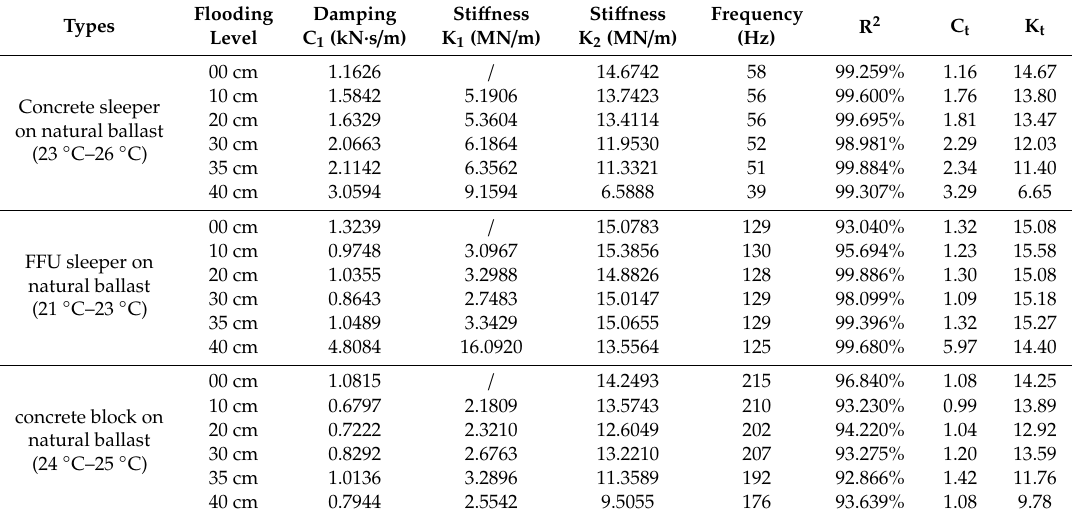
Table 5. The dynamic properties of ballast in Model-3.